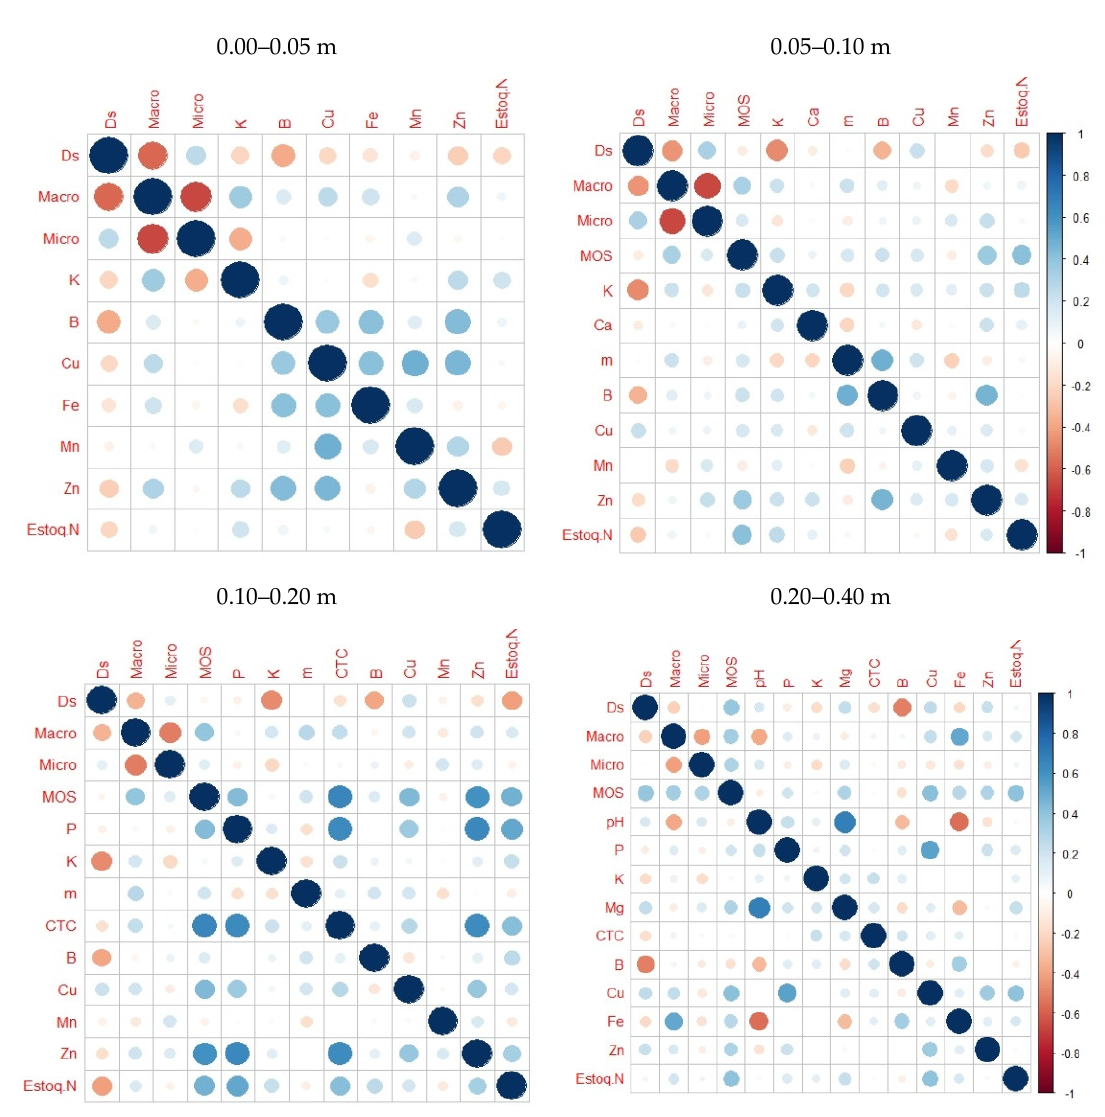
Figure 5 . Variables selected at each depth to be used in the Random Forest model to predict soil carbon stock for different land use systems. Bd—bulk density (kg dm − 3 , Macro—macroporosity (m 3 m − 3 ), Micro—microporosity (m 3 m − 3 ), SOM—soil organic matter (g dm − 3 ), pH—potential hydrogen, P—available phosphorus content (mg dm − 3 ), K—potassium content (mmol c dm − 3 ), Ca—calcium content (mmol c dm − 3 ), Mg—magnesium content (mmol c dm − 3 ), m—saturation